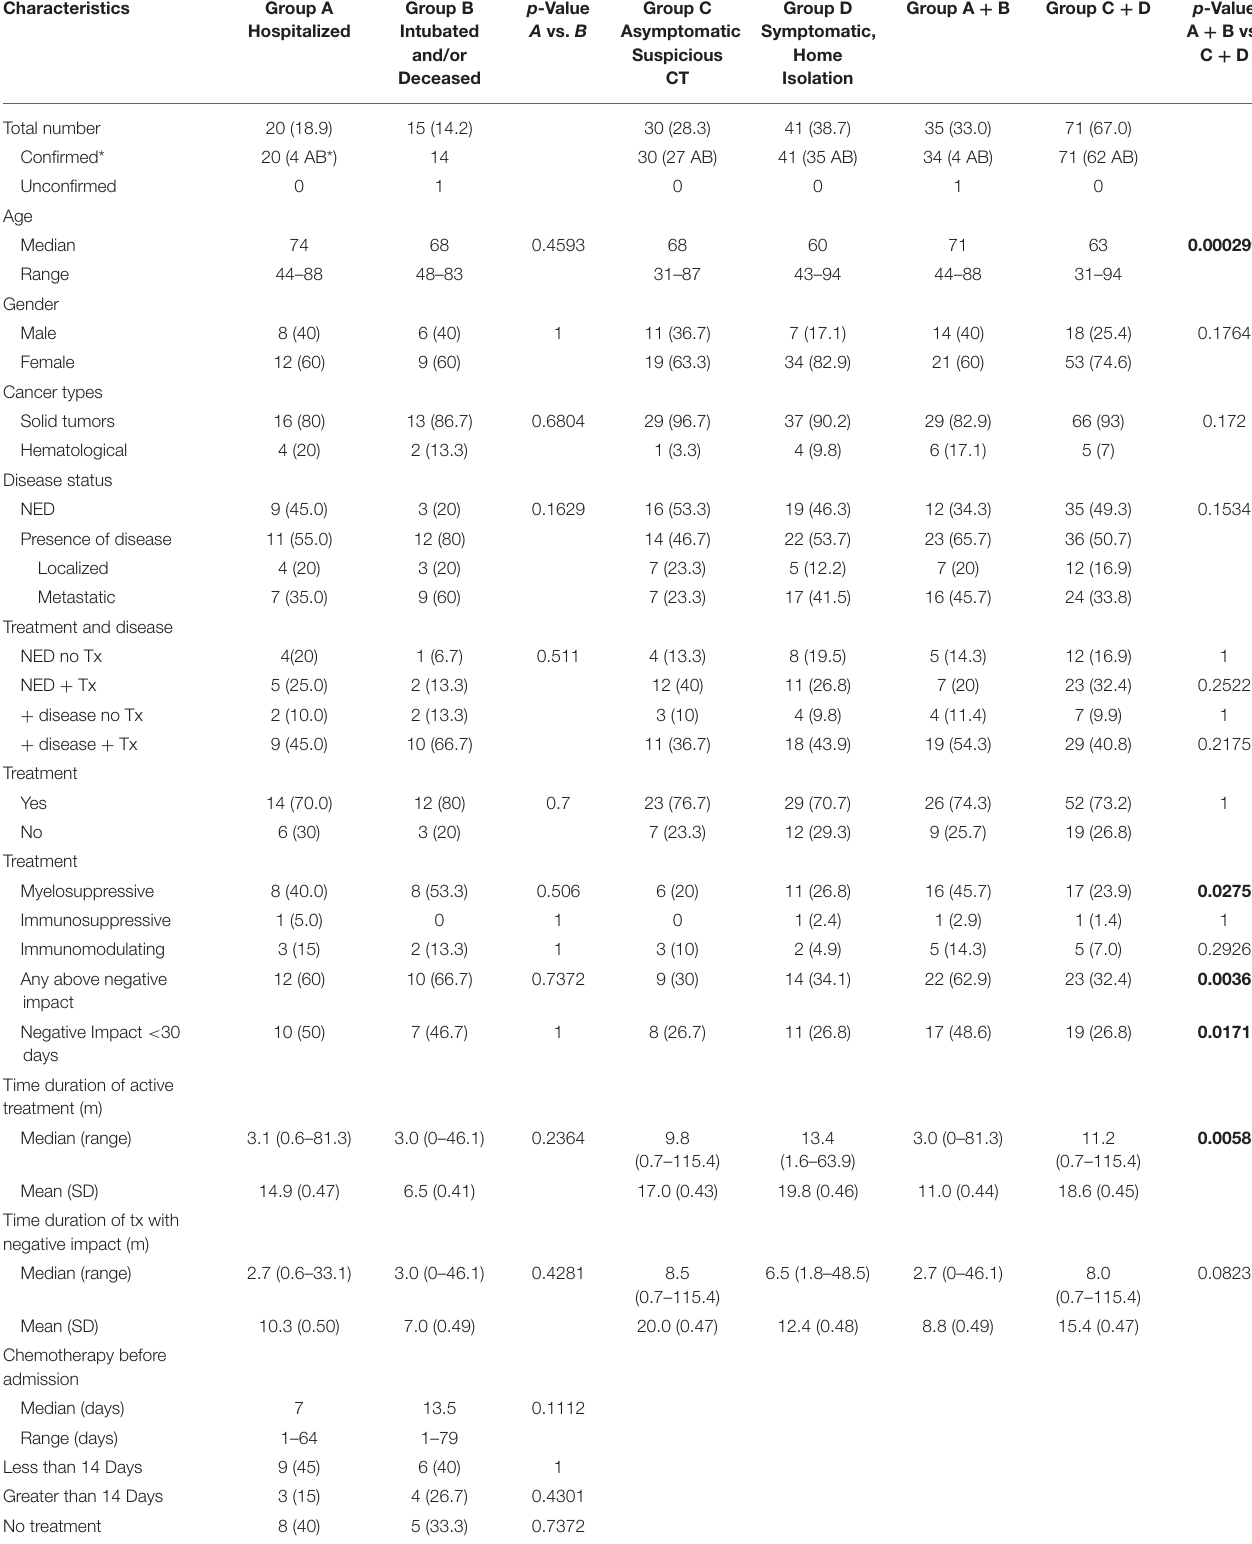
TABLE 2 | Clinical characteristics of patients divided by groups of severity of SARS-CoV-2 infection. Characteristics Group A